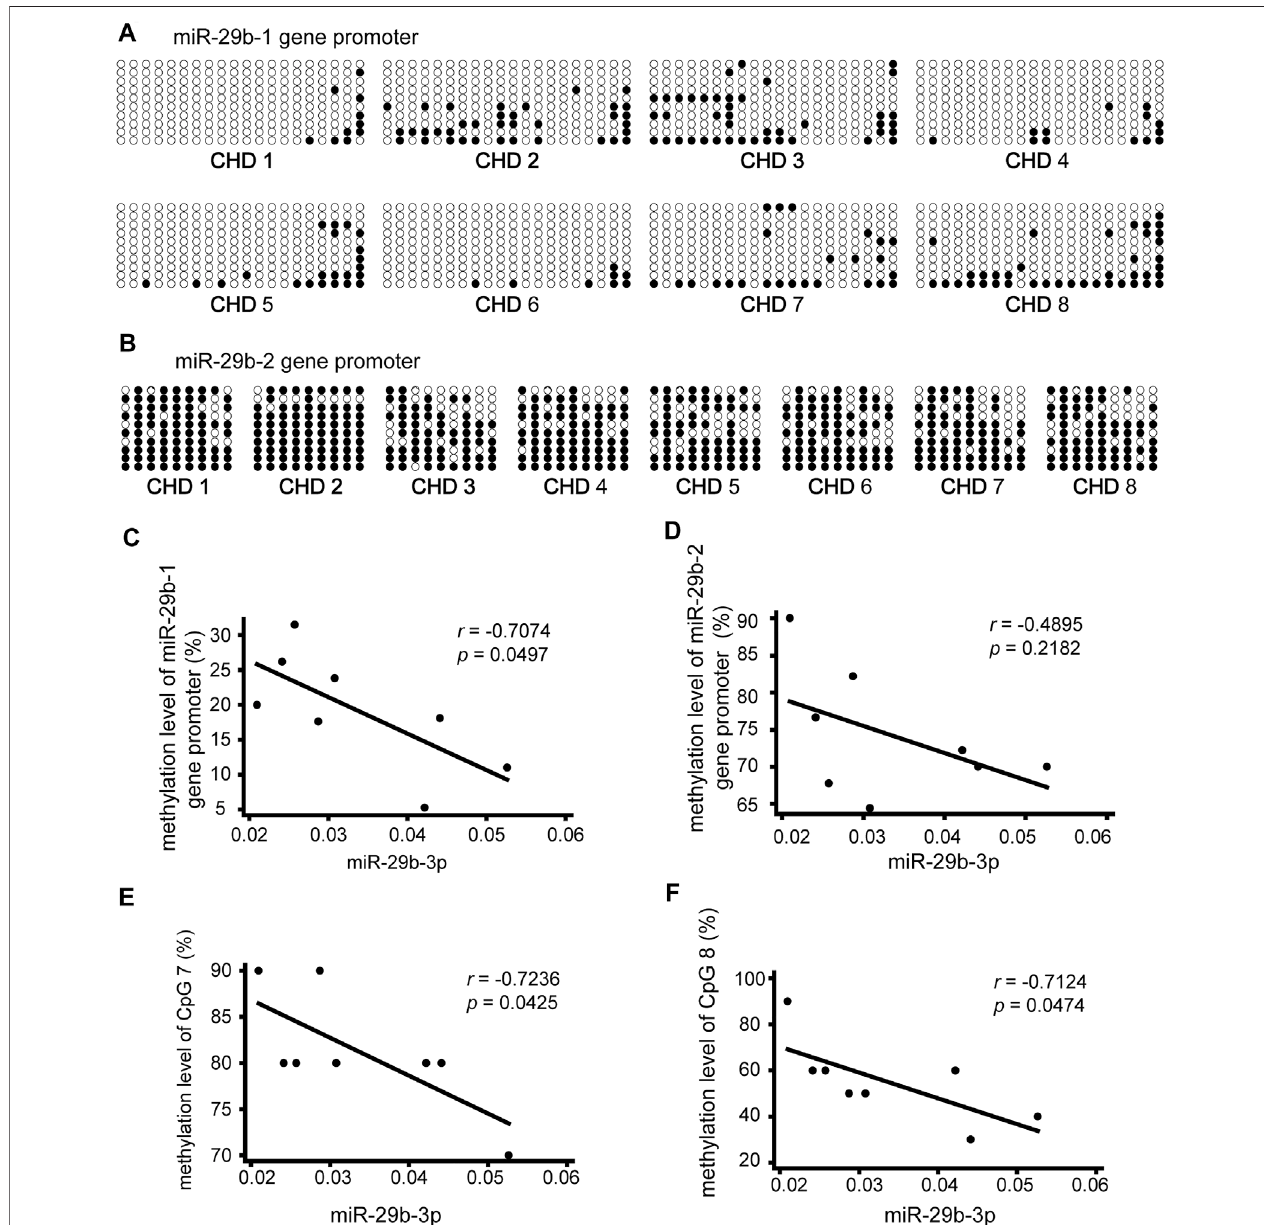
FIGURE3| AssociationofmiR-29b-3pexpressionwithitsmethylationstatusineightpatientswithCHD. (A and B) Methylationstatusofthepromoterregionofthe miR-29b-1 gene and miR-29b-2 gene. The black and white circles represent methylated and unmethylated CpG dinucleotides, respectively. (C) Correlations between miR-29b-3p expression and the methylation status of the miR-29b-1 gene (r = − 0.7074, p = 0.0497, and N = 8). (D) Correlations between miR-29b-3p expression and themethylationstatusofthemiR-29b-2gene(r= − 0.4895, p =0.2182,andN=8). (E) CorrelationsbetweenmiR-29b-3pexpressionandthemethylationstatusof CpG 7 located in the miR-29b-2 gene (r = − 0.7236, p = 0.0425, and N = 8). (F) Correlations between miR-29b-3p expression and the methylation status of CpG 8 located in the miR-29b-2 gene (r = − 0.7124, p = 0.0474, and N = 8). Spearman ’ s correlation tests were used.